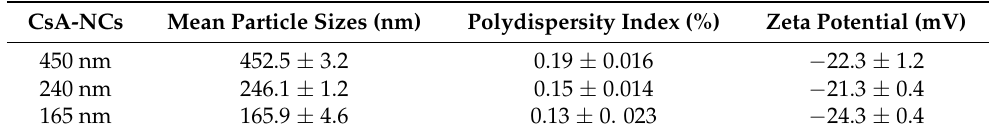
Table 1. Particle size, PDI and zeta potential of CsA-NCs ( n = 3, mean ±